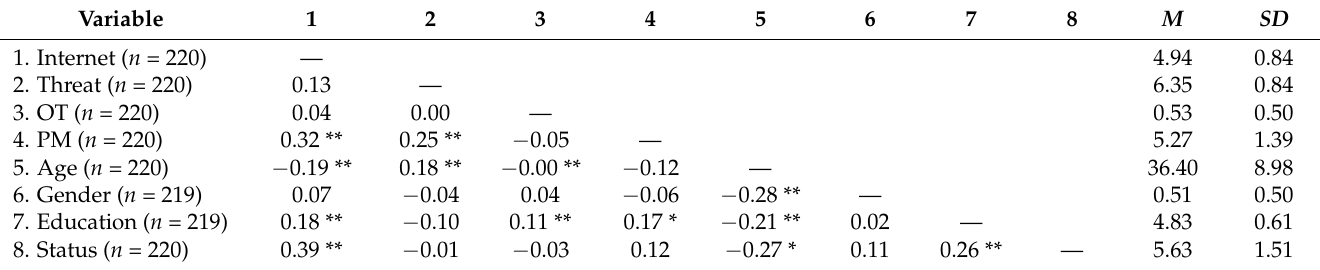
Table 2. Means, standard deviations, and intercorrelations among variables (Wave